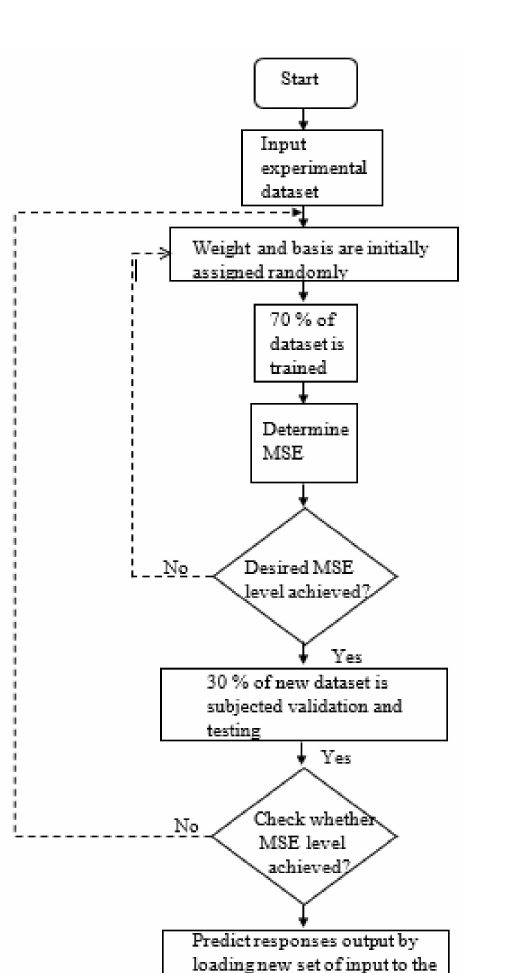
Figure 3. Flow diagram of the artificial neural network used in this study.